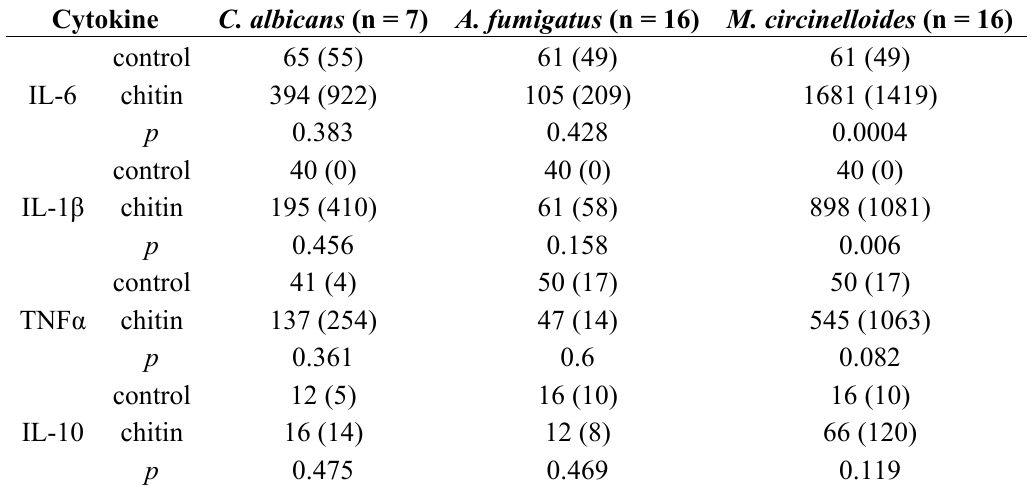
Table 4. Cytokines produced by hPBMCs after exposure to 2 k chitin purified from hyphae